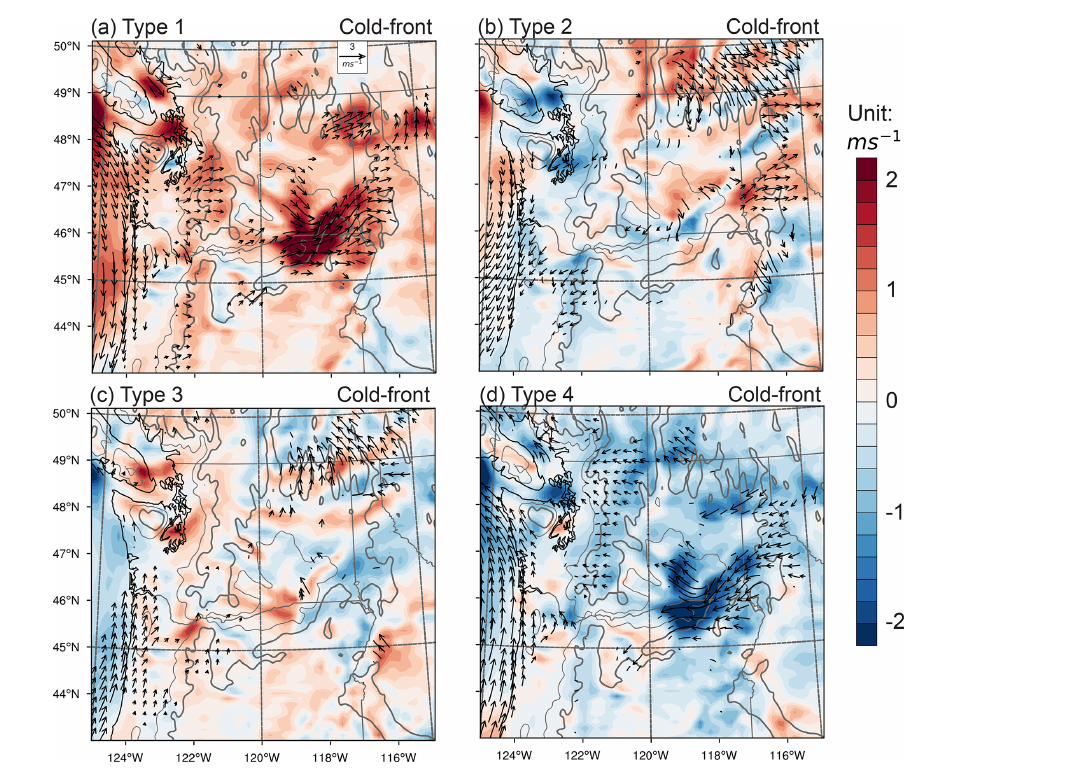
Figure 8. The same as Fig. 5 but for the cold-front case.